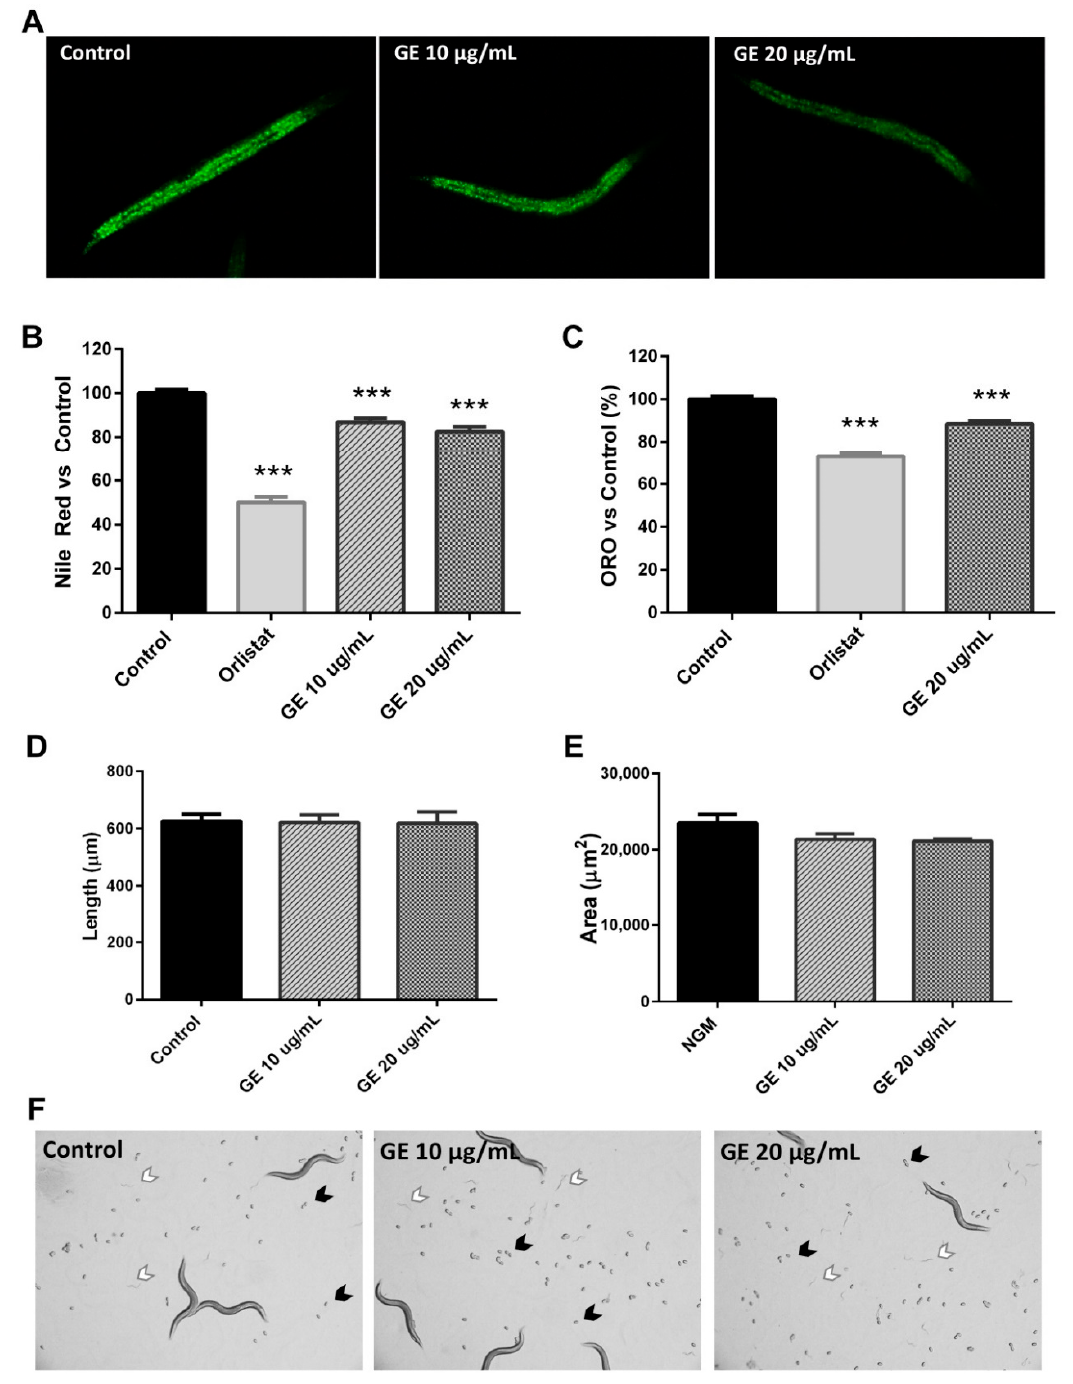
Figure 2. Grifola frondosa extract (GE) reduces the fat content of C. elegans from L1 to L4 independently of the effect on worm development. ( A ) Microscopic visualization of the worm fat content of control and GE (10 and 20 μ g/mL)-treated worms after staining with Nile Red. ( B ) Nile Red staining quantification of control and GE-treated (10 and 20 μ g/mL) worms. Orlistat (6 μ g/mL) was used as the positive control. ( C ) Oil Red O staining quantification of control and GE-treated worms (20 μ g/mL). ( D ) Length ( μ M) of GE-treated and untreated worms on day 1 of adulthood. ( E ) Area ( μ M 2 ) of GE-treated and untreated worms on day 1 of adulthood. All results are expressed as the mean ± SEM relative to NGM control worms. Significance refers to the effect of the treatments with respect to NGM control worms (ANOVA followed by LSD test, *** p < 0.001). ( F ) Microscope observation of the presence of eggs (black arrows) and L1 larvae (white arrows) in control (NGM) and GE-supplemented plates.